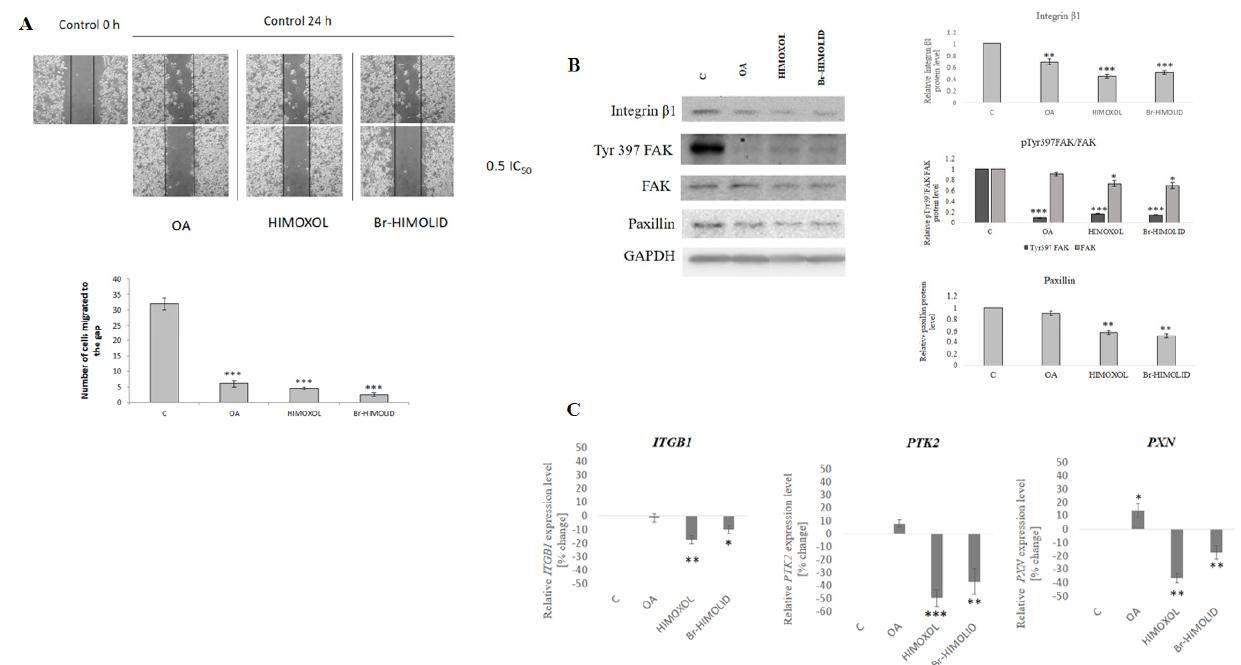
Figure 7. Influence of OA and its derivatives on migration of SK-BR-3 cells. ( A ) Effect of OA and its derivatives, HIMOXOL and Br-HIMOLID, on wound healing in SK-BR-3 breast cancer cells. Cells were scraped with a pipette tip and treated with OA or its derivatives in a concentration corresponding to 0.5 × IC 50 for 24 h. The photos represent cell migration under the microscope at 100 × magnification before (Control, 0 h) and after scratch. The experiments were repeated three times. *** p < 0.001 compared to the control group. ( B ) Contribution of OA and its derivatives to adhesion and migration of breast cancer cells. Evaluation of integrin β 1, FAK, and paxillin protein accumulation in the SK-BR-3 cells (8 × 104) was performed using immunodetection followed by densitometry analysis. Cells were treated with OA and its derivatives (Br-HIMOLID and HIMOXOL) in a concentration corresponding to 0.5 × IC50 for 24 h. The mean of three independent experiments ± SD is shown with p values calculated from paired data. Statistically significant difference versus control samples is shown: * p < 0.05; ** p < 0.005; *** p < 0.001. ( C ) Contribution of OA and its derivatives to the expression of genes contributing to a migration-associated pathways in breast cancer cells. SK-BR-3 cells (8 × 104) were treated with OA, Br-HIMOLID, or HIMOXOL for 24 h. Expression of target genes (integrin β 1, FAK, and paxillin) was evaluated using specific primers and qPCR, relative to housekeeping gene GAPDH. Data from three independent experiments are shown as mean ± SD. The mean of three independent experiments ± SD is shown with p -values calculated from paired data. Statistically significant difference versus control samples is shown: * p < 0.05; ** p < 0.005; *** p < 0.001.